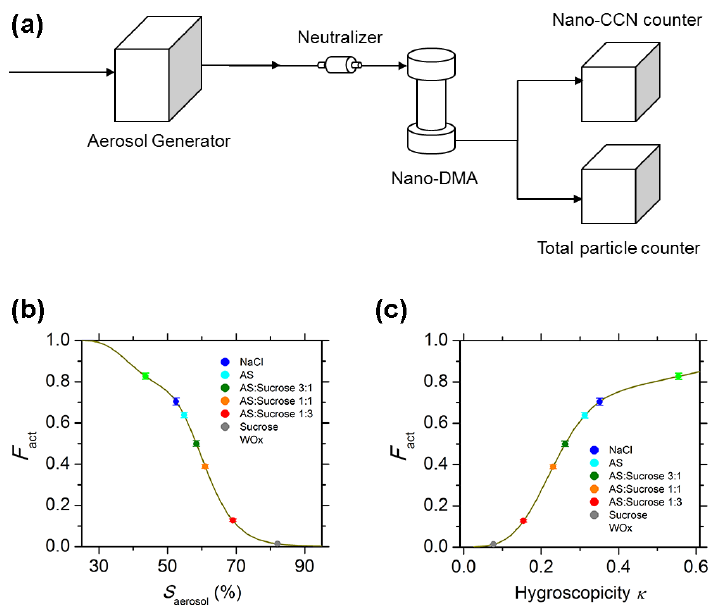
Figure 6. (a) Schematic of the setup for nano-CCNC measurements; (b) dependence of activation fraction F act on the aerosol activation supersaturation S aerosol and (c) hygroscopicity κ for aerosols of dry diameter 2.5nm. The solid line represents the calibration curve. The dots represent measurement results of different compounds in which AS denotes ammonium sulfate and WOx denotes tungsten oxides. The error bars represent the uncertainties of F act